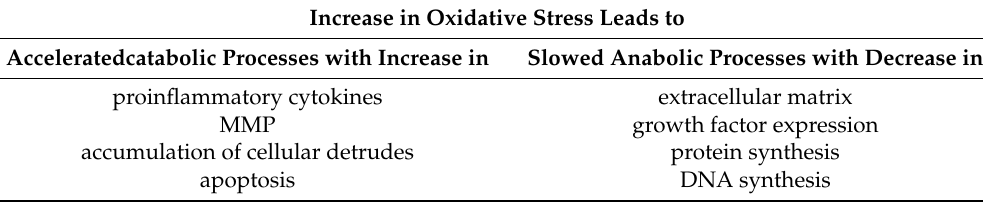
Table 2. Oxidative stress, aging and